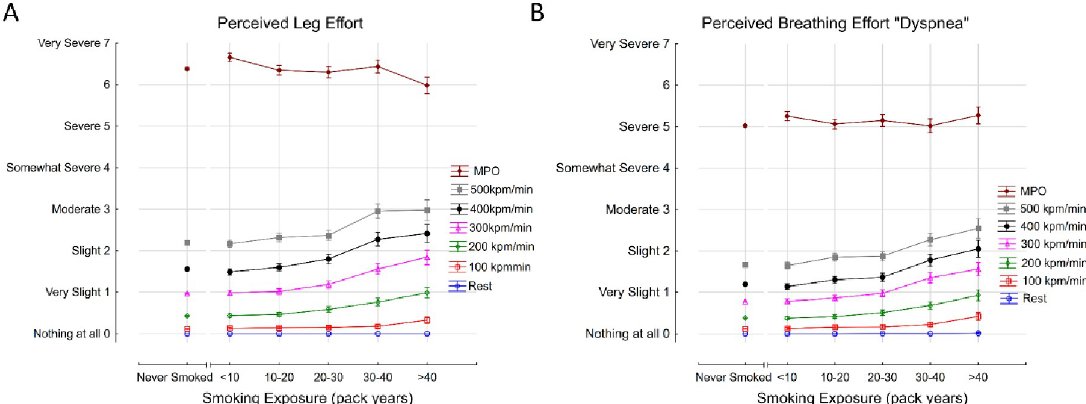
Fig 5. Association between cigarette smoke exposure and perceived leg (A) and breathing (B) effort during CPET. MPO; maximum power output.